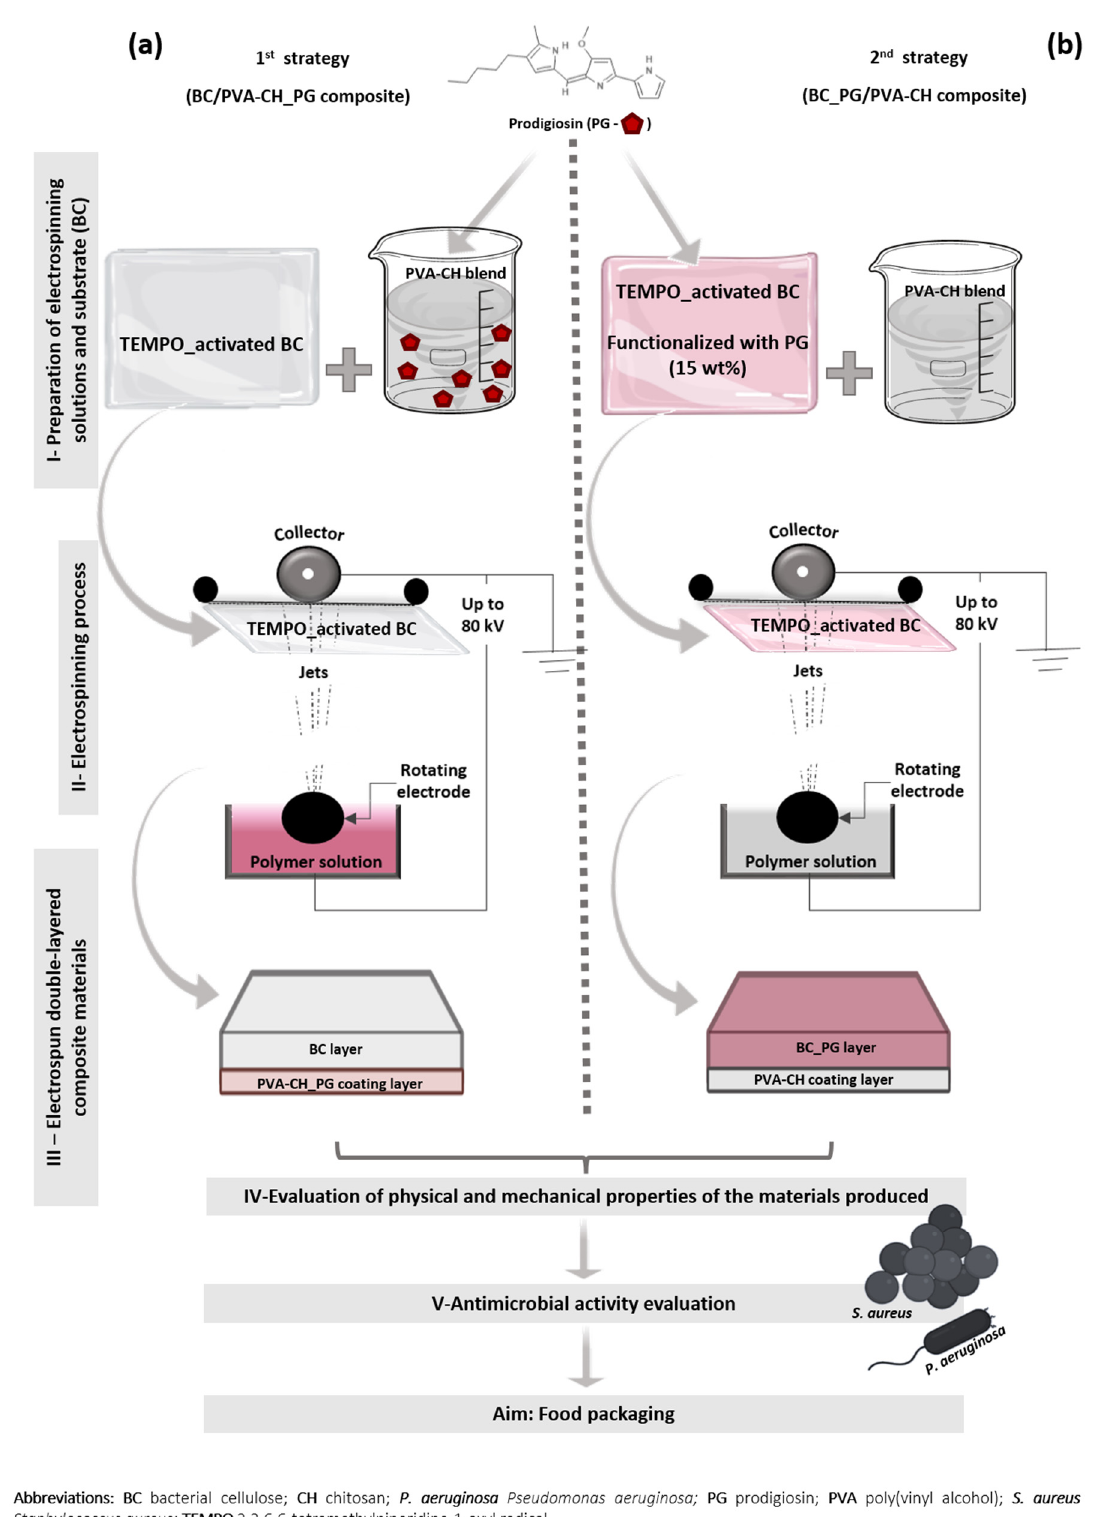
Figure 1. Schematic representation of the production strategies used in composites preparation ( a ) BC/PVA-CH_PG composite, with TEMPO-activated BC, used as a substrate for PVA-CH_PG nanofibers deposition and ( b ) BC_PG/PVA-CH composite, with PVA-CH nanofibers deposition in TEMPO-activated BC, previously functionalized with PG.